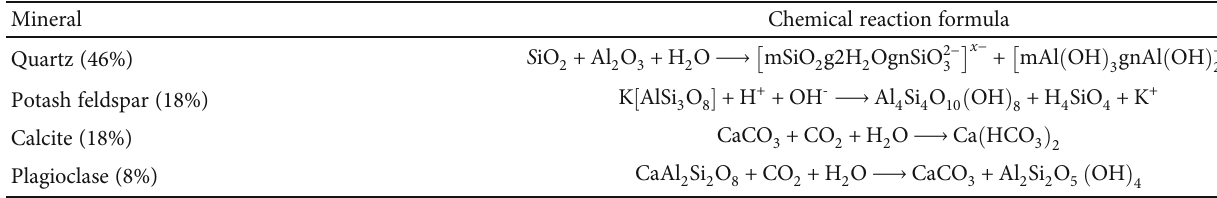
Table 4: Possible chemical reactions between water and minerals during water immersion.